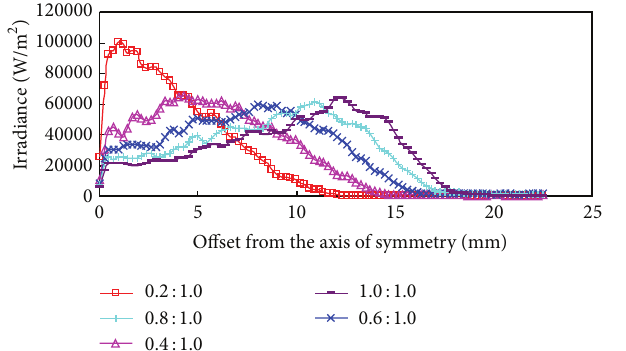
Figure 6: The irradiance distribution of absorbing surface at different depth-to-width ratio.